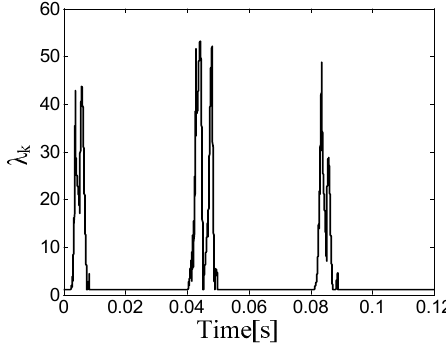
Figure 17. Fading factors of speed step response.